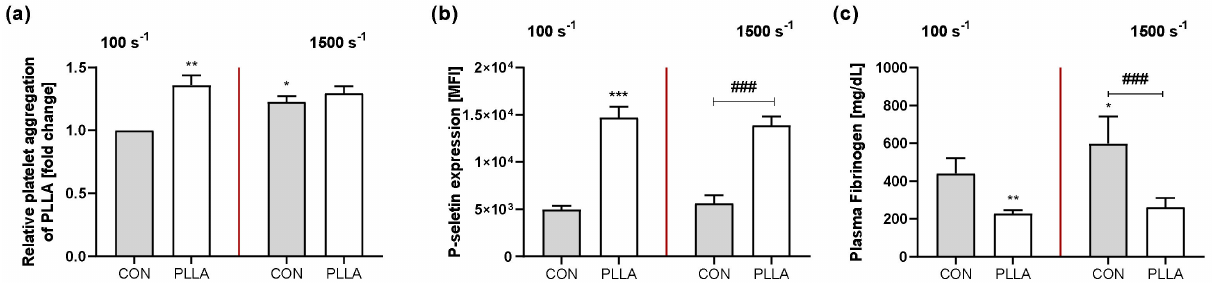
Figure 1. PLLA influences platelet aggregation and activation. Human platelets were circulated through a parallel plate flow chamber system, containing either no polymer or the indicated materials, for 5 min with shear rates of 100 s − 1 and 1500 s − 1 : ( a ) After flow exposure, collagen-induced platelet aggregation was measured. ( b ) Subsequent FACS analysis was performed immediately after flow exposure. Therefore, PRP was collected and platelets were stained for P-selectin. ( c ) PRP was collected for ELISA measurement of soluble fibrinogen. Bars show mean ± SD of 5 independent experiments compared to a polymer-free control. Significances to the corresponding control are given with * p < 0.05, ** p < 0.01 and *** p < 0.001. Significances between groups are given as ### p <